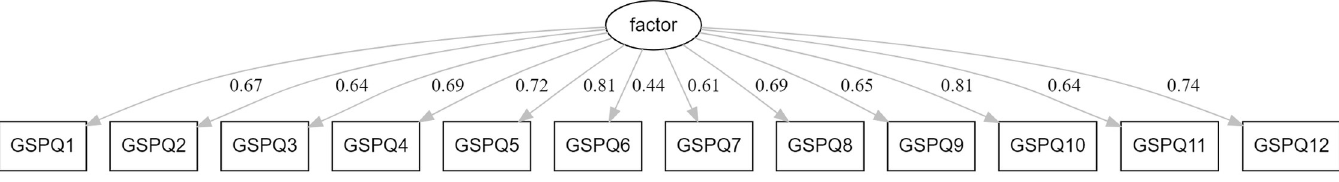
Fig 4. Standardized solution of the GSPQ one-factor model in a Polish sample.